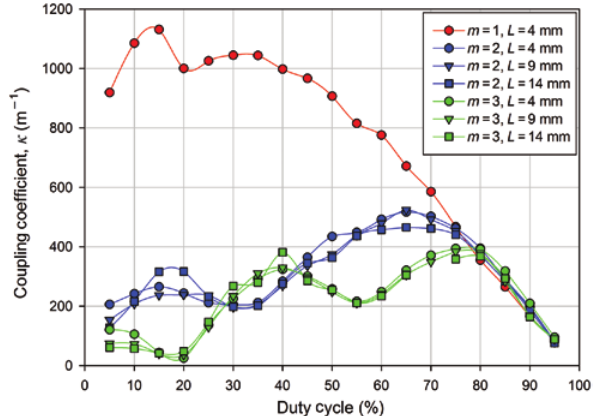
Figure 7: Coupling coefficients κ of C-band WBGs fabricated in a silicate glass (Schott IOG-10) using the modulated burst method. Various duty cycles, WBG lengths ( L ), and orders ( m ) are